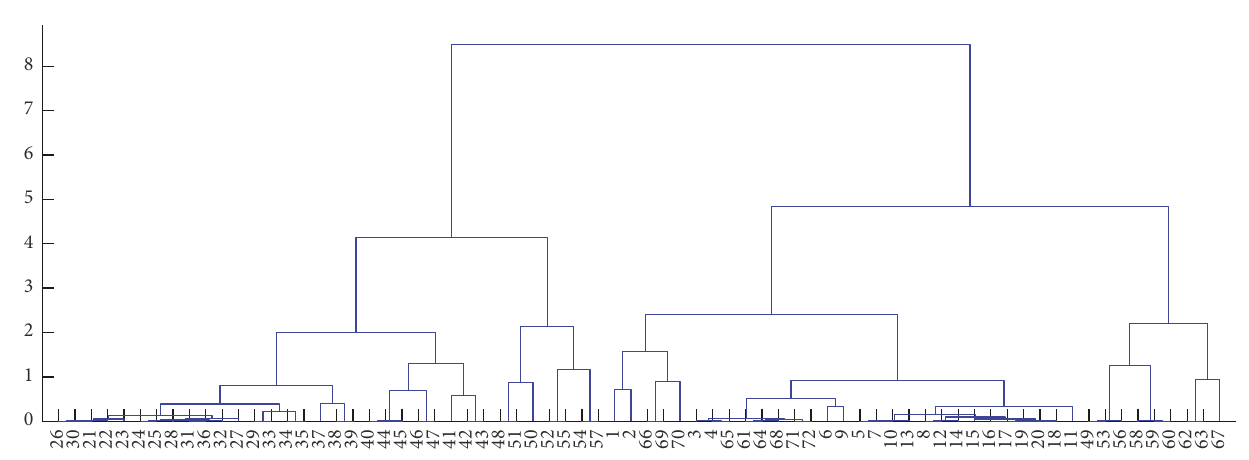
Figure 5: The hierarchical clustering graphs of the MDD group and the healthy group. The number in the graphs corresponds to the name of channels: 1-F10, 2-AF8, 3-AF4, 4-F2, 5-FCz, 6-FP2, 7-Fz, 8-FC1, 9-FPz, 10-AFz, 11-Cz, 12-F1, 13-FP1, 14-AF3, 15-F3, 16-AF7, 17-F5, 18-FC5, 19-FC3, 20-C1, 21-F9, 22-F7, 23-FT7, 24-C3, 25-CP1, 26-FT9, 27-T7, 28-C5, 29-CP3, 30-T9, 31-T3, 32-TP7, 33-CP5, 34-P5, 35-P3, 36-TP9, 37-T5, 38-P7, 39-P1, 40-Pz, 41-PO7, 42-PO3, 43-O1, 44-POz, 45-Oz, 46-PO4, 47-O2, 48-P2, 49CP2, 50-PO8, 51-P8, 52-P4, 53-CP4, 54-T6, 55-P6, 56-CP6, 57-TP10, 58-TP8, 59-C6, 60-C4, 61-C2, 62-T4, 63-T8, 64-FC4, 65-FC2, 66-T10, 67-FT8, 68-FC6, 69-FT10, 70-F8, 71-F6, and